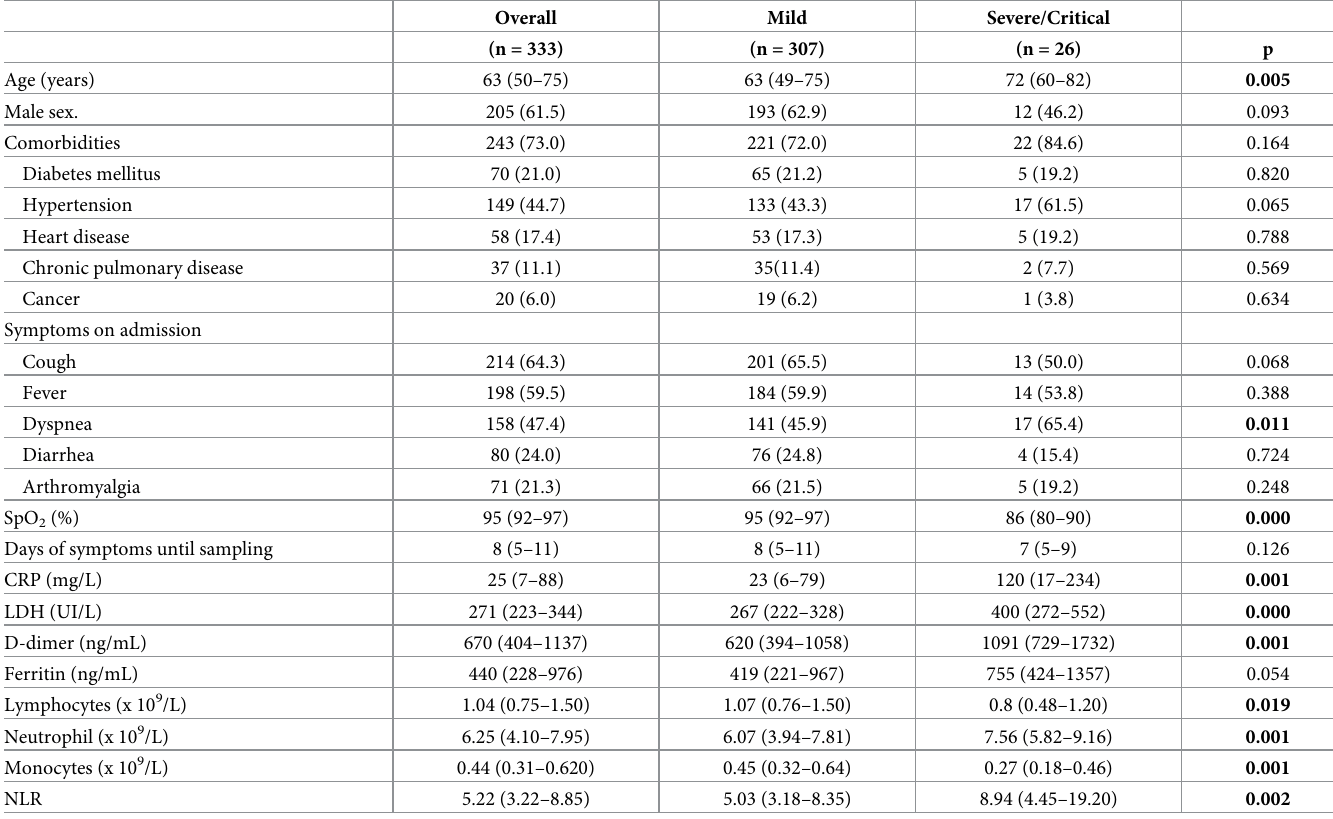
Table 1. Baseline characteristics of the